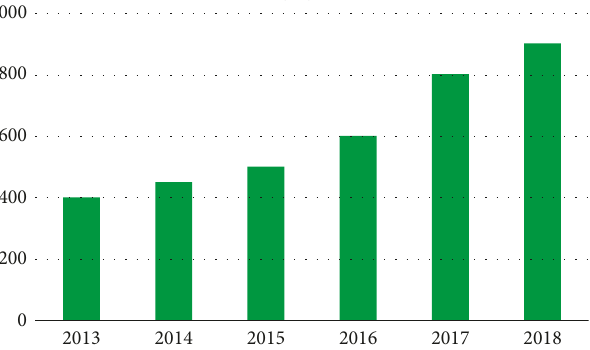
Figure 3: The amount of electricity from